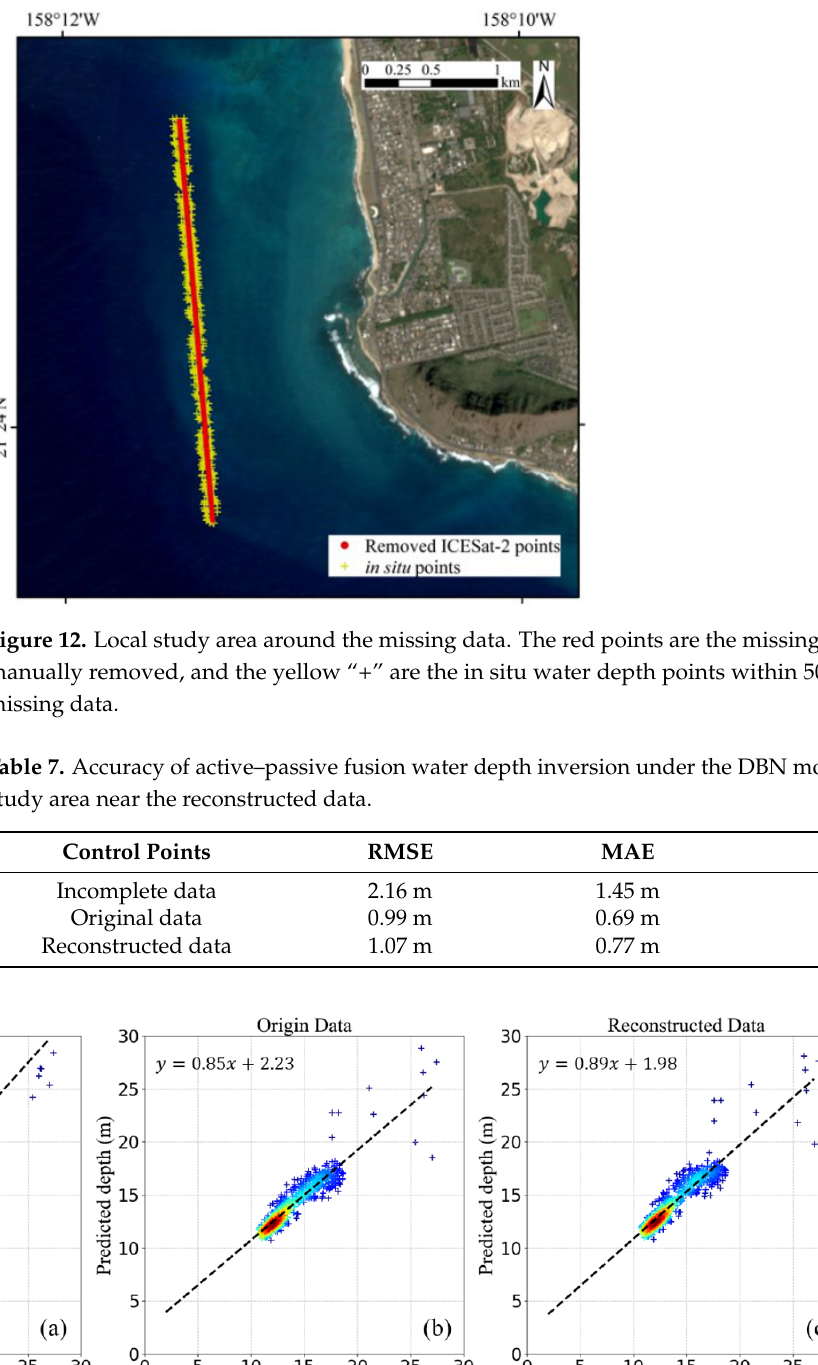
Table 7. Accuracy of active – passive fusion water depth inversion under the DBN model in the local study area near the reconstructed data. Figure 13. Scatterplots of water depth inversion in the local study area based on three sets of training data: ( a ) results based on incomplete data, ( b ) results based on complete original data, and ( c ) results based on reconstructed data.